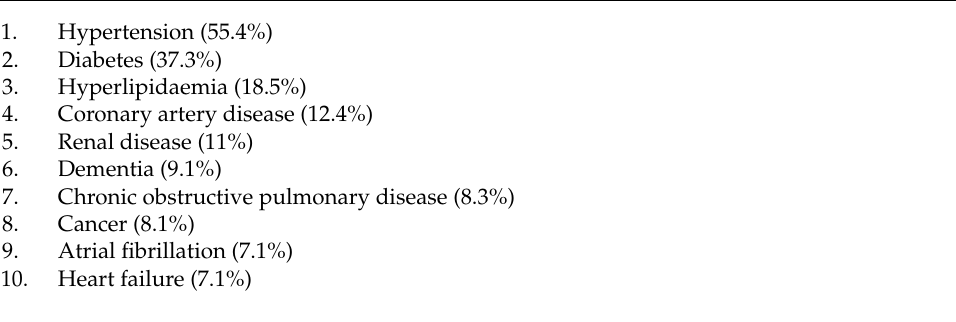
Table 2. Showing relationship of COVID-19 with various comorbid conditions